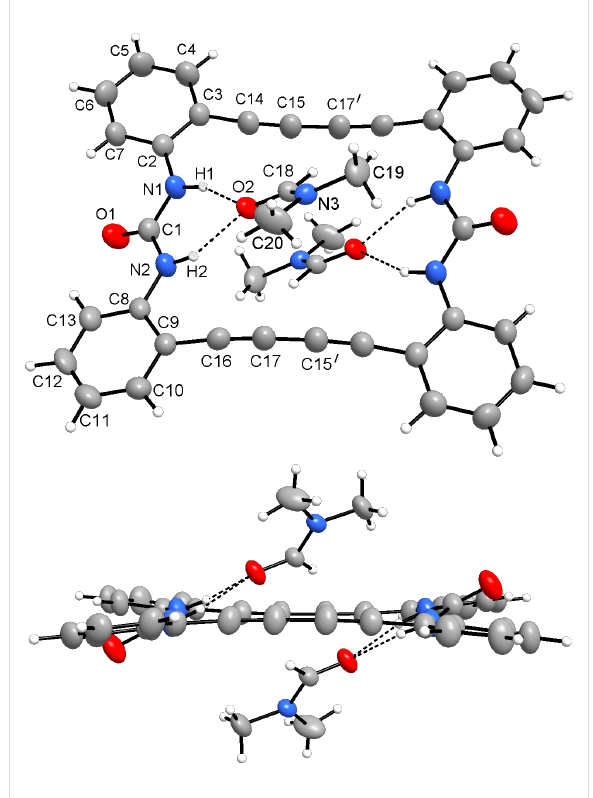
Figure 1: The molecular structure of 2 ·2DMF in two different views, on top perpendicular to the plane, on bottom in the plane of the macro- cycle. The molecular complex bears an inversion centre in the midpoint. Thermal ellipsoids are scaled at the 50% probability level. For a figure of the molecular structure of 2 ·2DMSO see Supporting Information File 1, Figure S9.